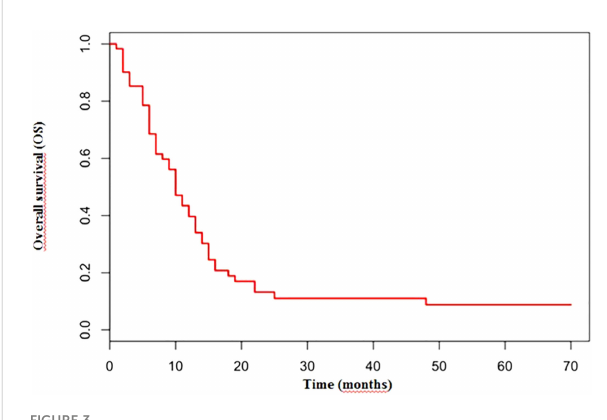
FIGURE 3 Median OS in overall population treated with platinum/etoposide mOS: 10 months.